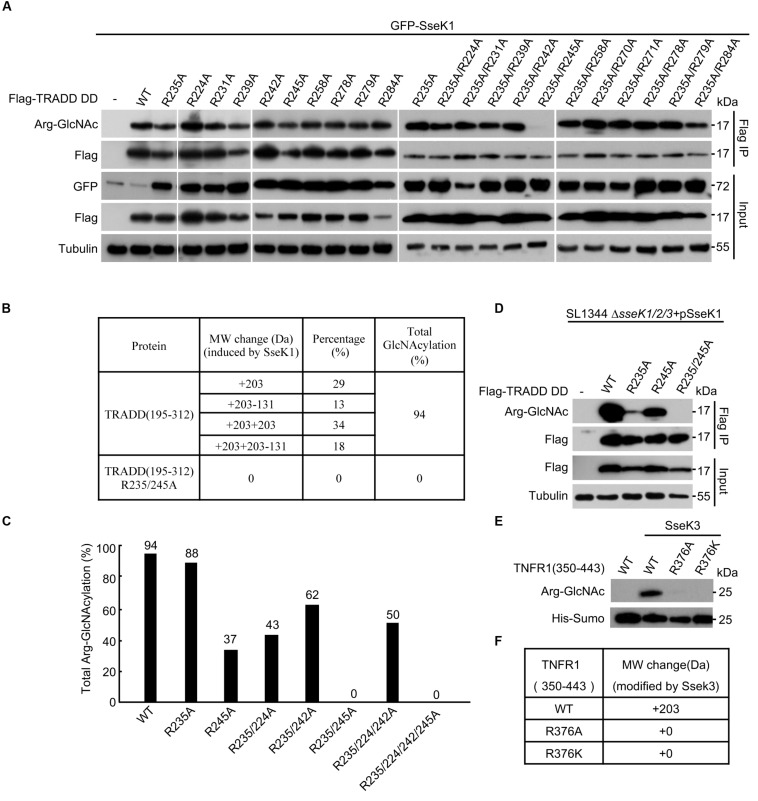
SseK1 GlcNAcylates hTRADD at R235/R245and SseK3 GlcNAcylates TNFR1 at R376. (A) An arginine point mutation screen of hTRADD to investigate its ability to be GlcNAcylated by SseK1. 293T cells were transfected with the indicated plasmid combinations. The samples of anti-Flag immunoprecipitates (Flag IP) and total cell lysates (Input) were immunoblotted with the corresponding antibodies. Anti-tubulin was used as a loading control. (B) Mass spectrometry summary of the total molecular weight of TRADD DD and TRADD DD (Arg235Ala/Arg245Ala) mutant co-expressed with SseK1 in bacteria. “ + 203” indicates a single GlcNAc modification. “ + 203-131” indicates in addition to a single GlcNAc modification, one methionine is missing as well. “ + 203 + 203” indicates two GlcNAc modifications. “ + 203 + 203-131” indicates in addition to two GlcNAc modifications, one methionine is missing as well. (C) Total Arg-GlcNAcylation modification percentages of TRADD and TRADD arginine mutants catalyzed by SseK1. (D) Modification of TRADD and TRADD variants by SseK1 upon S. Typhimurium infection. Plasmids carrying genes for Flag-TRADD DD, Flag-TRADD DD R235A, Flag-TRADD DD R245A, and Flag-TRADD DD R235/245A transfected into 293T cells were infected with the indicated Salmonella strains. After infection, cells were lysed and proteins were immunoprecipitated with Flag beads, followed by standard immunoblotting analysis with the indicated antibodies. (E) TNFR1 WT and Arg376 mutants co-expressed with SseK3 in BL21. Bacterial lysates were subjected to SDS-PAGE, followed by immunoblotting analyses as shown. (F) Summary of ESI-MS determination of the total mass of TNFR1 and its mutants co-expressed with SseK3 in bacteria. Data in (A–D) are from at least three independent experiments.